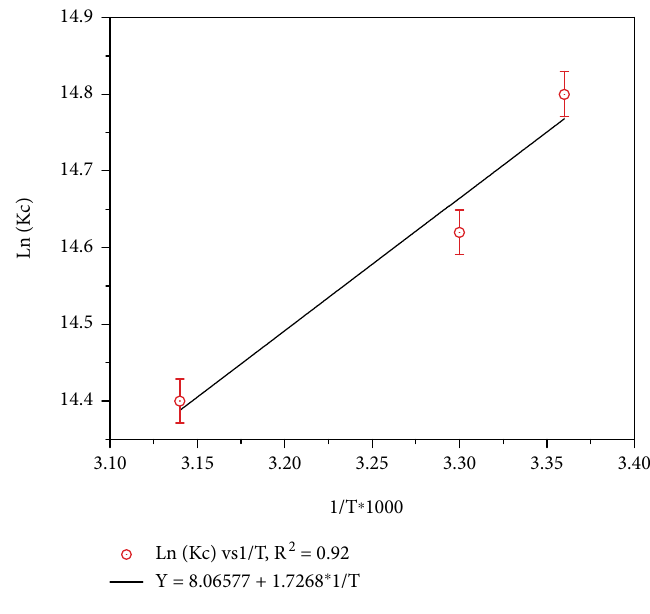
Figure 9: Plot of LnK vs. 1/T. C Table 6: Thermodynamic parameters for the adsorption of phosphorus by